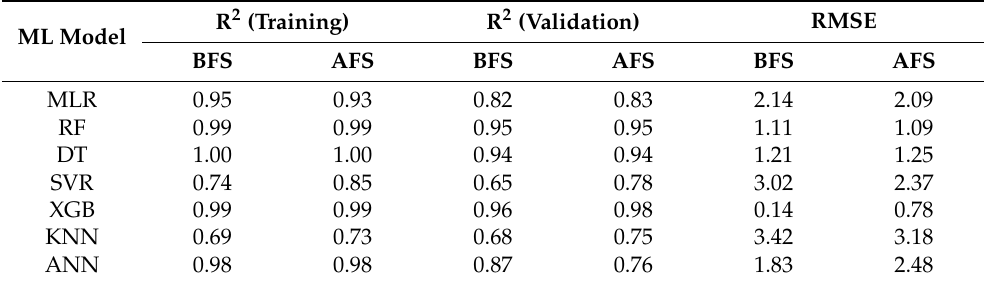
Figure 6. Correlation matrix plot between chlorophyll content and different vegetation indices for the AFS method. Table 6. Performance comparison of the different ML